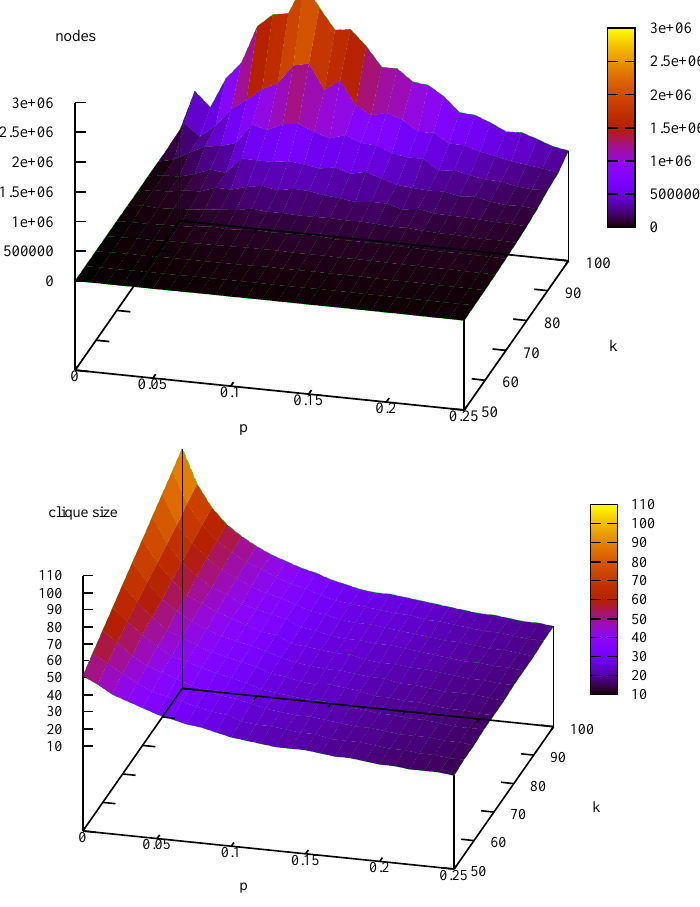
Figure 10. Small world graphs SW (200 , k, p ) : (upper) search effort, (lower) maximum clique